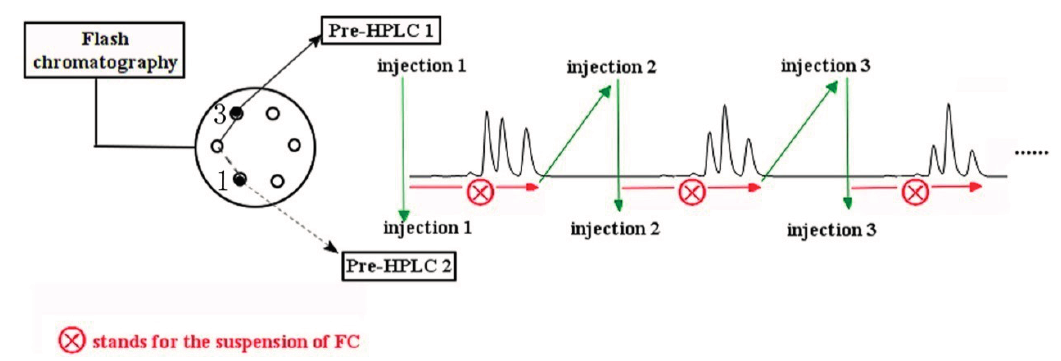
Figure 3. Scheme showing intermittent sample injection performed during offline mode separation. After injection 1 on the prep-HPLC 2 was complete, the valve was switched back to position 1. The second injection (injection 2) was carried out after the loop was fully filled with the elutions, to eliminate peak overlap caused by the short injection intervals.